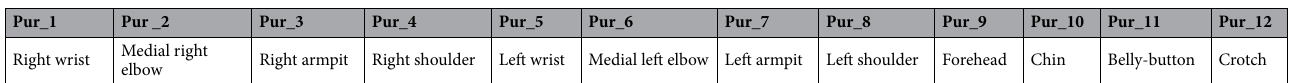
Table 1. A comparison table of Purhor information and body surface